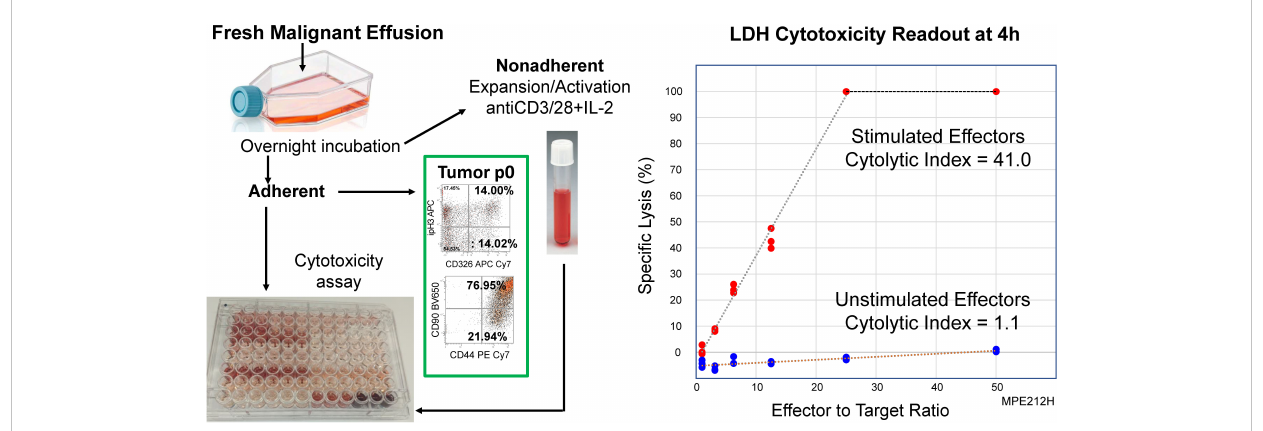
FIGURE 4 Activated PIT are cytolytic to autologous tumor. A T-cell enriched fraction was obtained from a freshly drained MPE (PE212H, Table 1) as non- adherent cells after overnight culture in a polystyrene fl ask. The T-cell enriched fraction was cultured in the presence (Stimulated) or absence (Unstimulated) of CD3/CD28 beads plus IL-2 for 14 days, after which time they were co-incubated with autologous tumor. Cytotoxicity was measured by LDH release after 4 hours in culture. Left Panel: Schematic of cytotoxicity assay. Right Panel: Cytotoxic activity was quanti fi ed as the cytolytic index, determined from the slope of the kill curve x 1000.